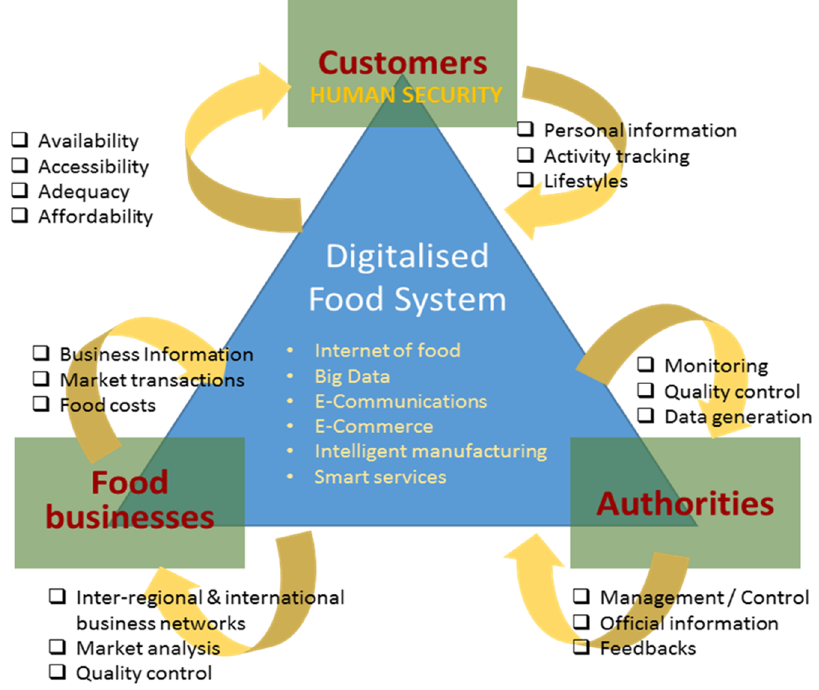
Figure 1. An overlapping relationship within a digitalized food system .